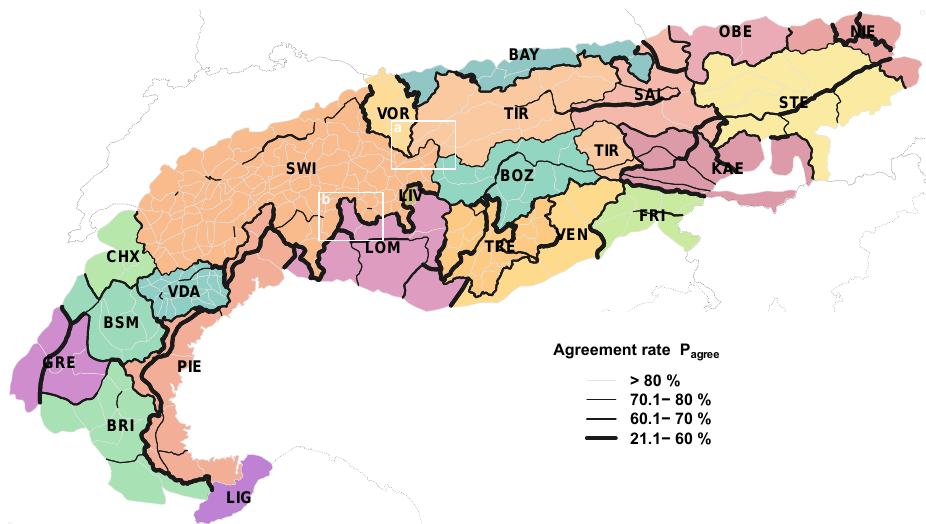
Figure 5. Map showing the individual forecast center domains in the European Alps (different colors, three-letter abbreviations; see Table 2). The borders between warning regions are highlighted depending inversely on the agreement rate P agree , with thicker lines corresponding to more frequent disagreements. The two white boxes (a, b) mark the two regions discussed in more detail in Sect. 5.7.